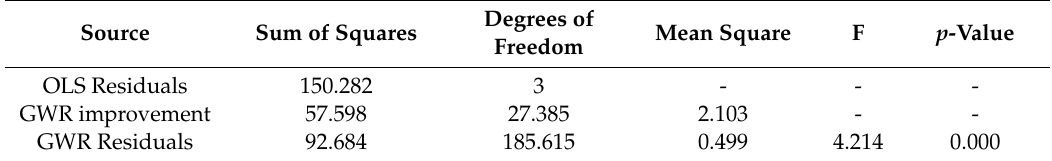
Table 4. ANOVA of the improvement in model fit of GWR over